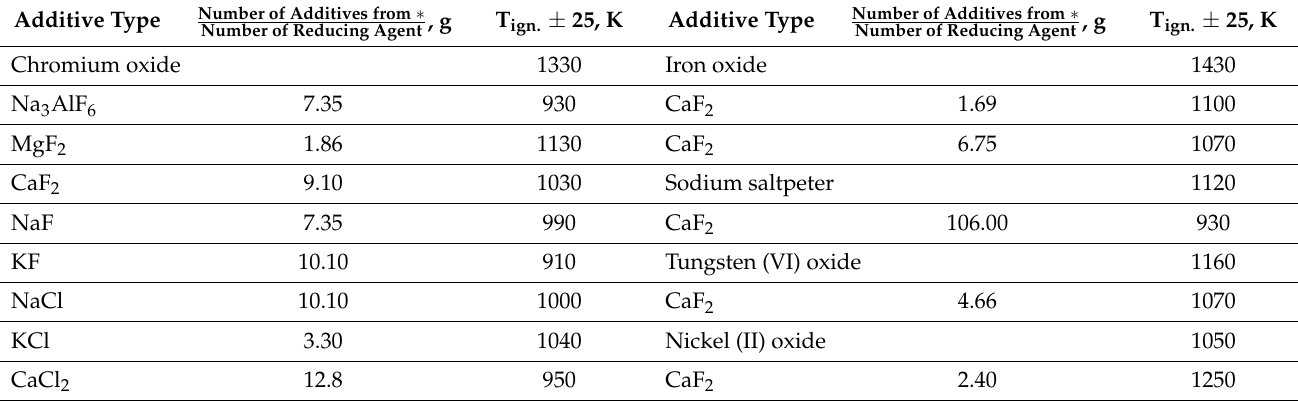
Table 4. The effect of salt additives on the ignition temperature of aluminothermic compositions. Additive